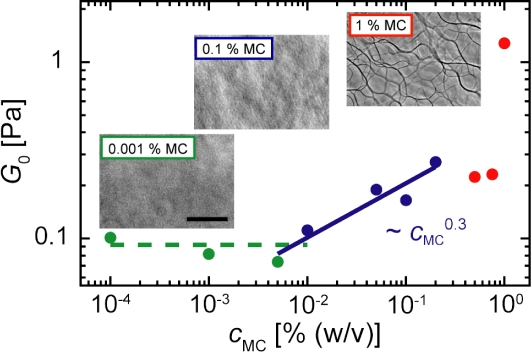
Plateau modulus of actin/MC solutions.The plateau modulus G
0 of actin/MC solutions is depicted as a function of MC concentration, c
MC. Three regimes can be distinguished: At low c
MC (below 0.01%, green) the plateau modulus is similar to that of an entangled F-actin solution. For intermediate c
MC (0.01–0.2%, blue) a weak increase in G
0∼c
MC
0.3 is observed. Above c
MC = 0.2% (red) the dependence of G
0 on c
MC becomes more complex. Insets: Phase contrast micrographs (scale bar: 20 µm).